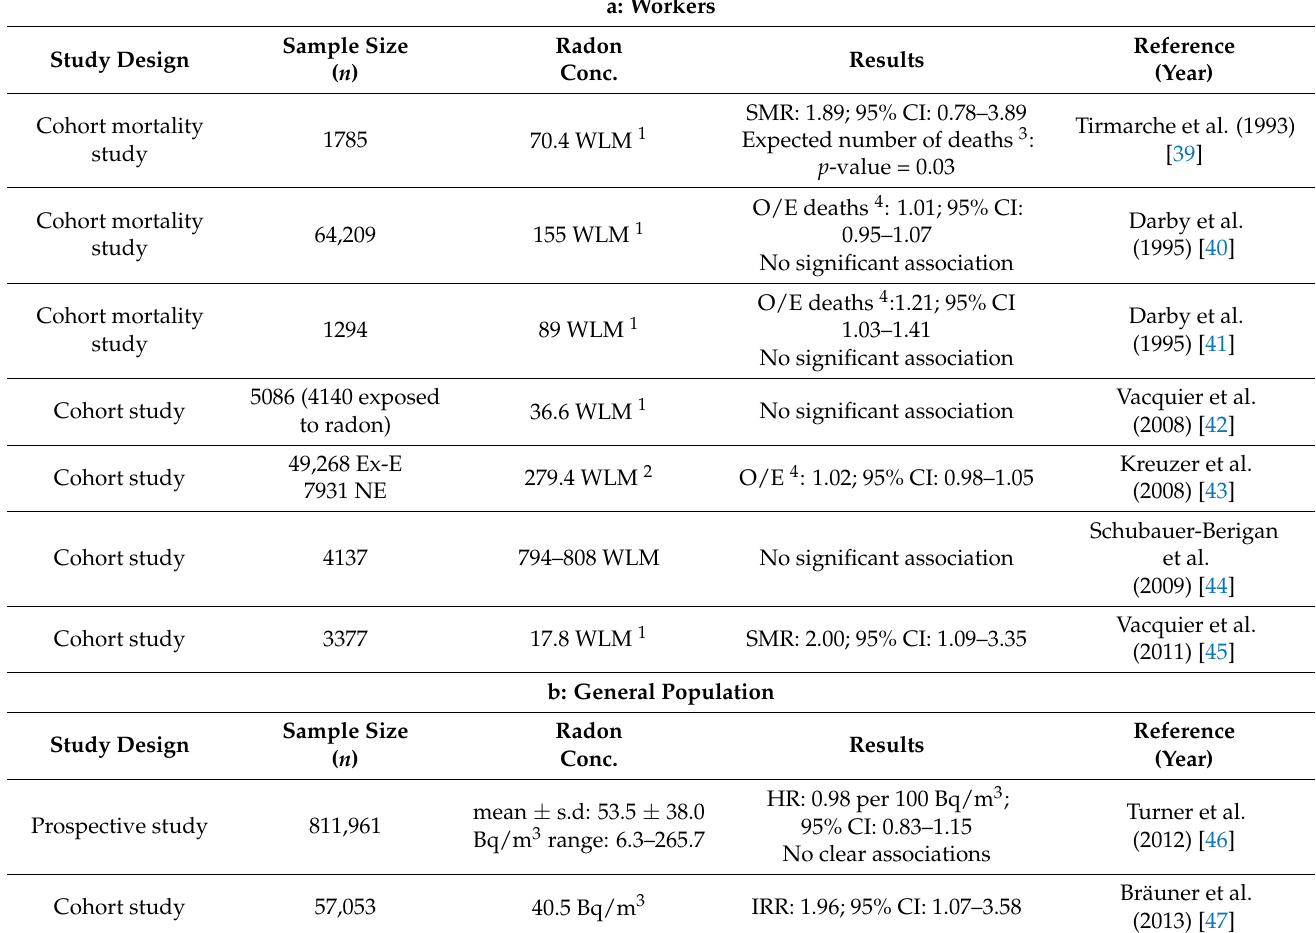
Table 1. Brain and Central Nervous System (CNS)